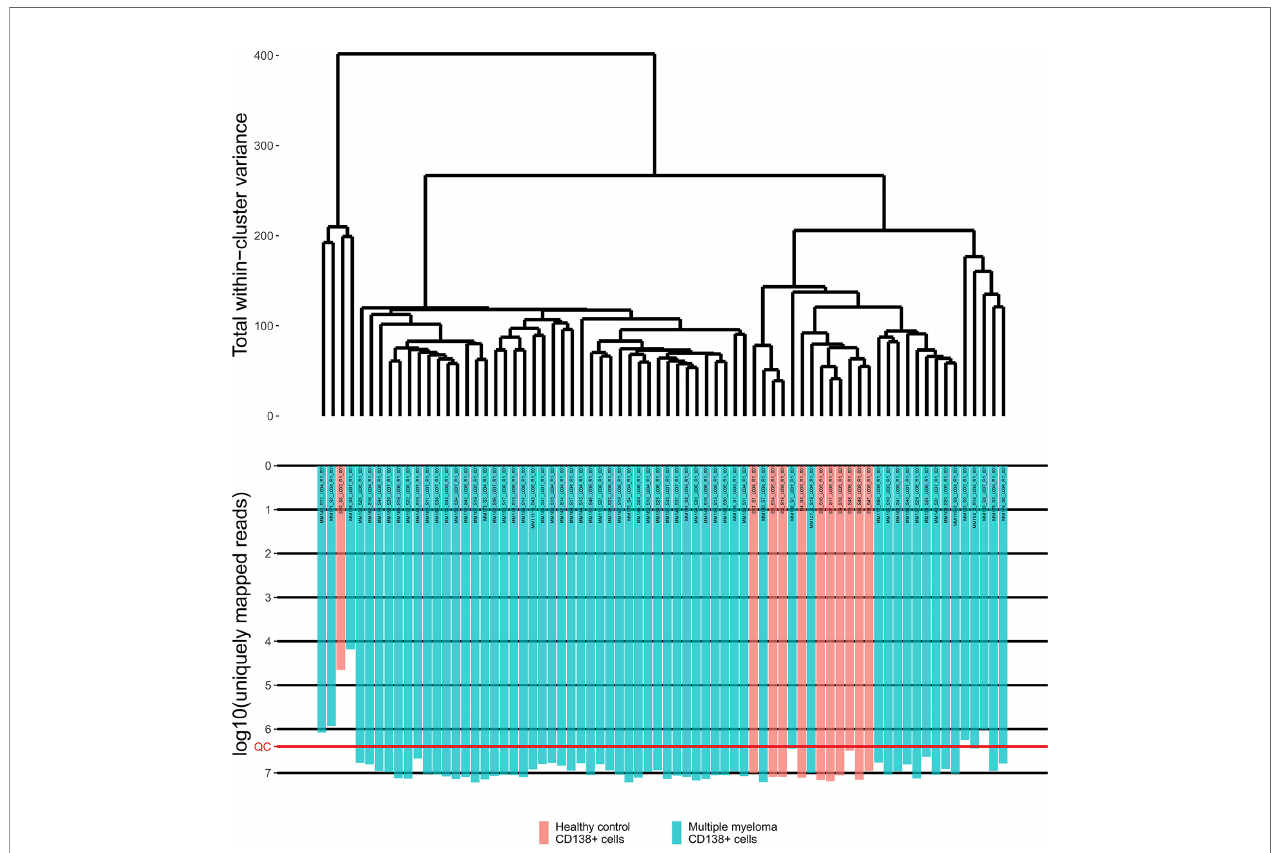
FIGURE 1 | The hierarchical clustering dendrogram of all experimental RNA sequencing pro fi les of the control and multiple myeloma samples. Gene expression data were used to calculate Euclidian distances between the samples. Color indicates the sample type. The lower scale indicates the number of uniquely mapped reads. QC denotes the quality control threshold of 2.5 million uniquely mapped